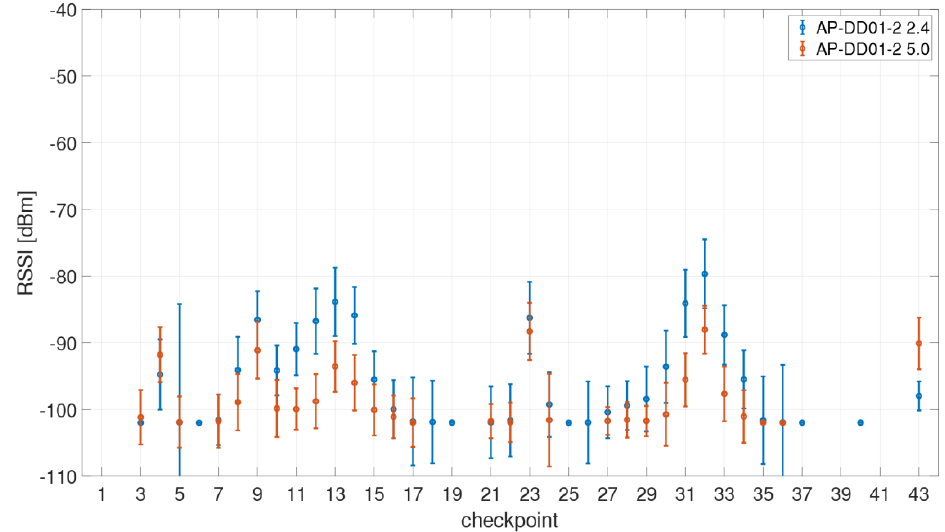
Figure 10. Sensed RSSIs of the AP DD01-2 from the first floor on all checkpoints for both the 2.4 and 5 GHz frequency bands.